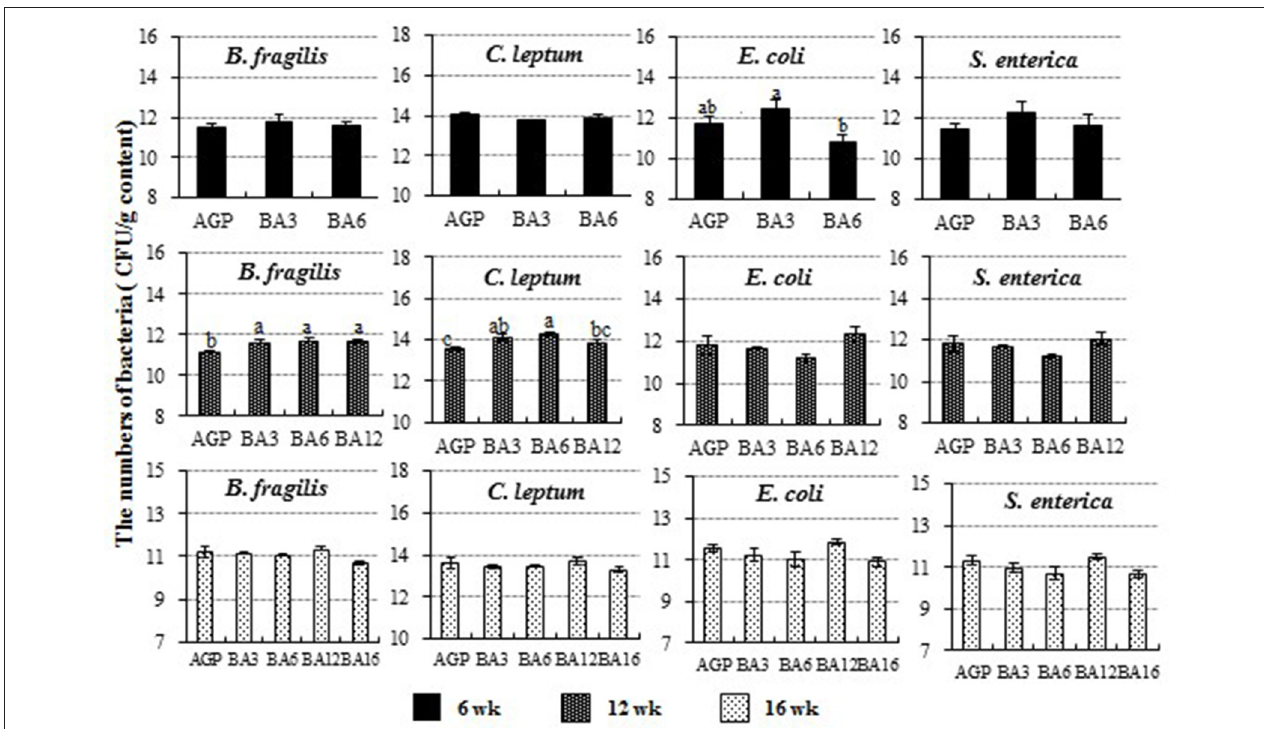
FIGURE 4 | The population of Clostridium leptum , Bacteroides fragilis , Escherichia coli, and Salmonella enterica in caecum of pullets from 0 to 16 weeks. The bars represent the numbers of the bacteria in caecum per g content, and different patterns represent different ages.